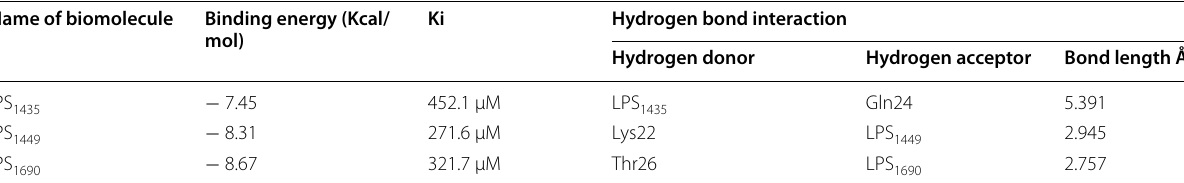
Table 6 Interaction results of β-defensin 1 with LPS of P. gingivalis